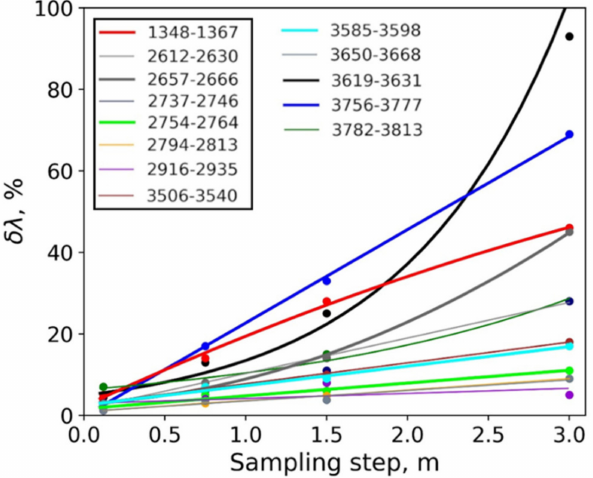
Figure 7. The dependence of relative error (relative uncertainty) in data on the equivalent thermal conductivity for the investigated depth intervals from the core sampling rate during thermo-physical investigations. There are intervals in the box that were involved while calculating the heat flow density due to the availability of data on the equilibrium temperature